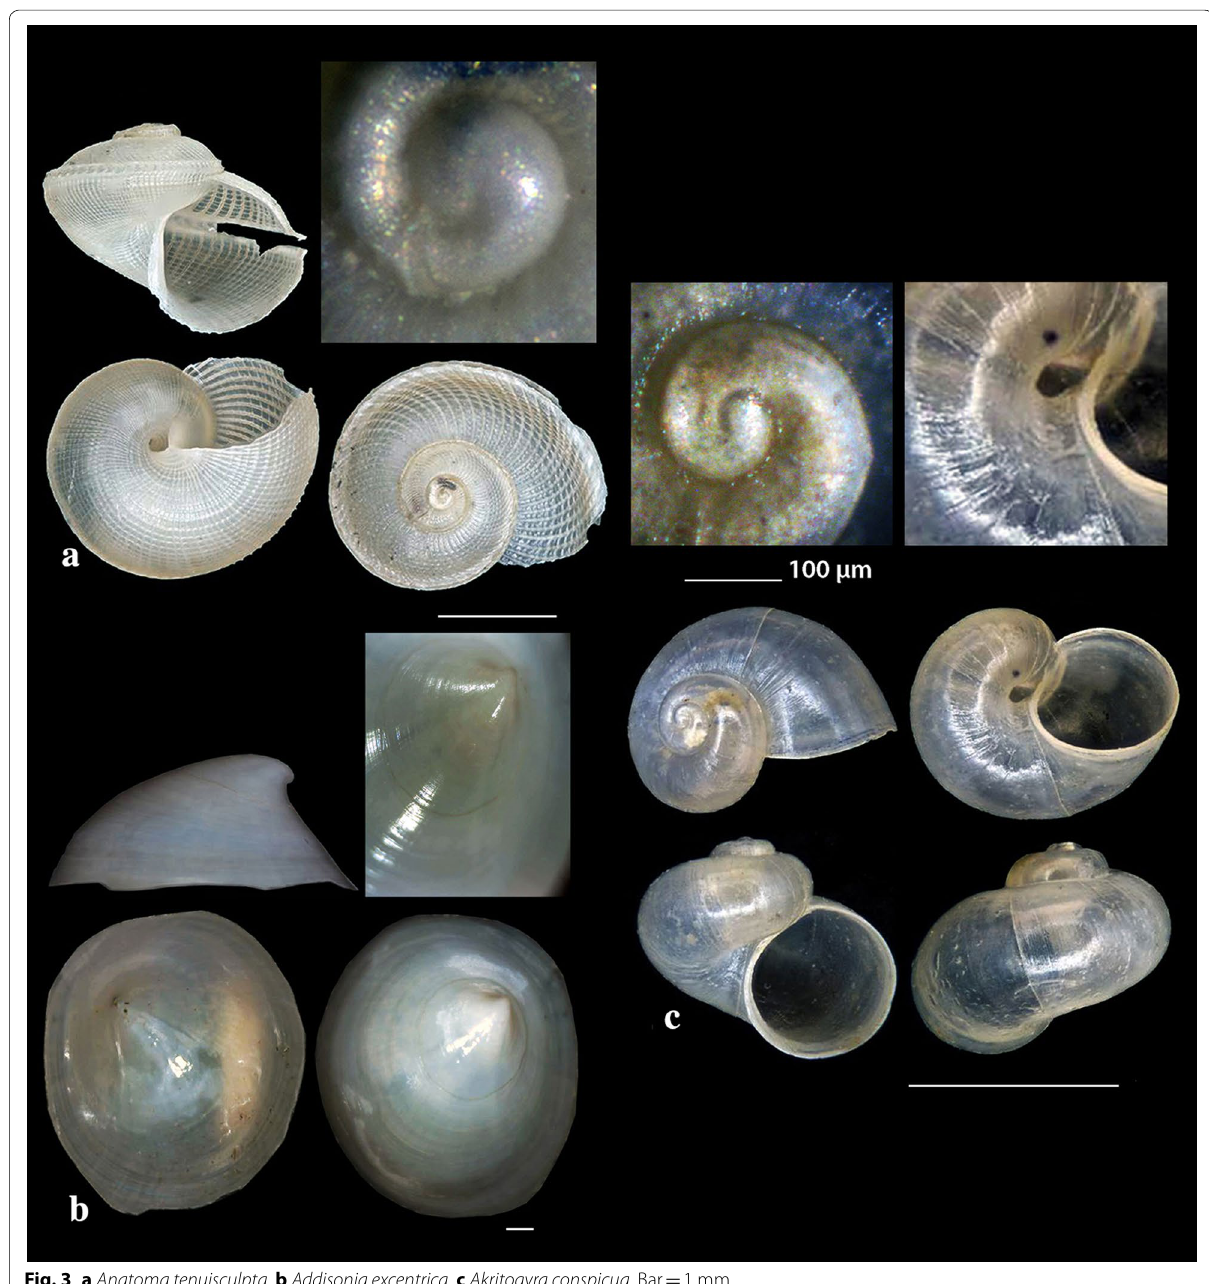
Fig. 3 a Anatoma tenuisculpta , b Addisonia excentrica , c Akritogyra conspicua . Bar